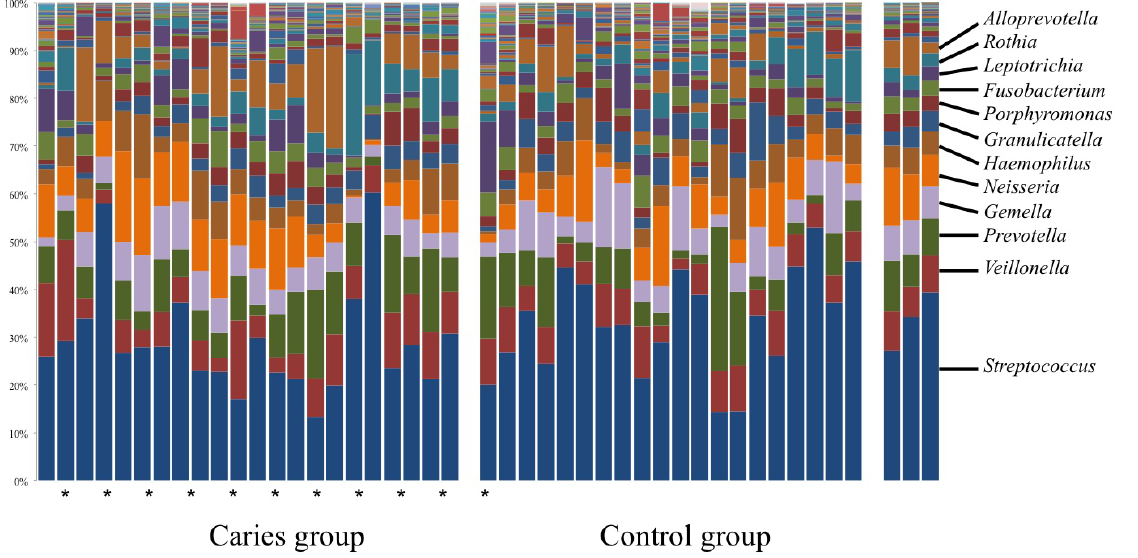
Figure 3. Distribution of the major bacterial genera among all participants.* Represents Children with